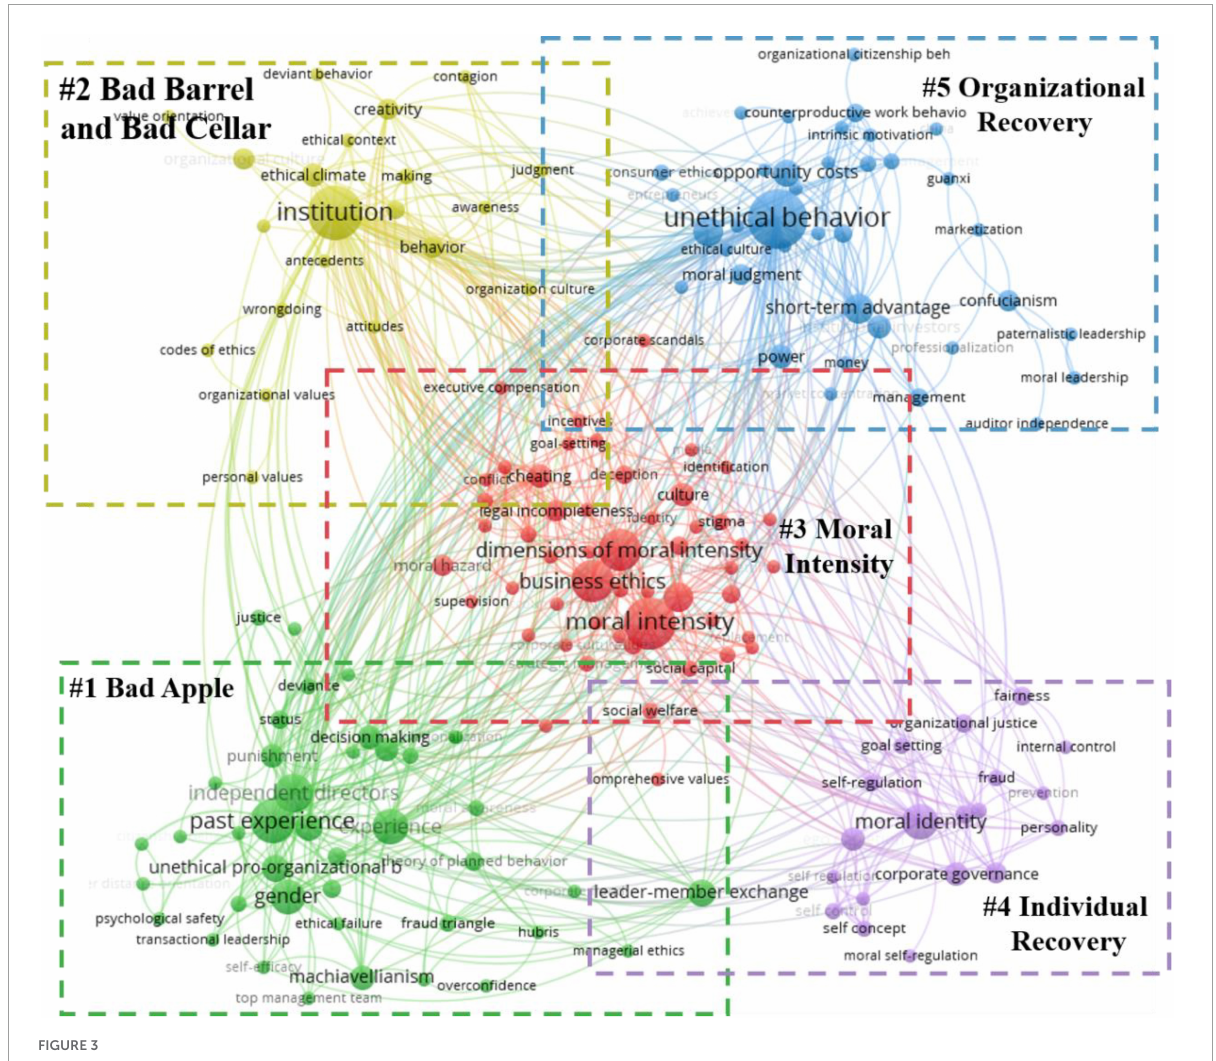
FIGURE3 The consequence of co-occurrence